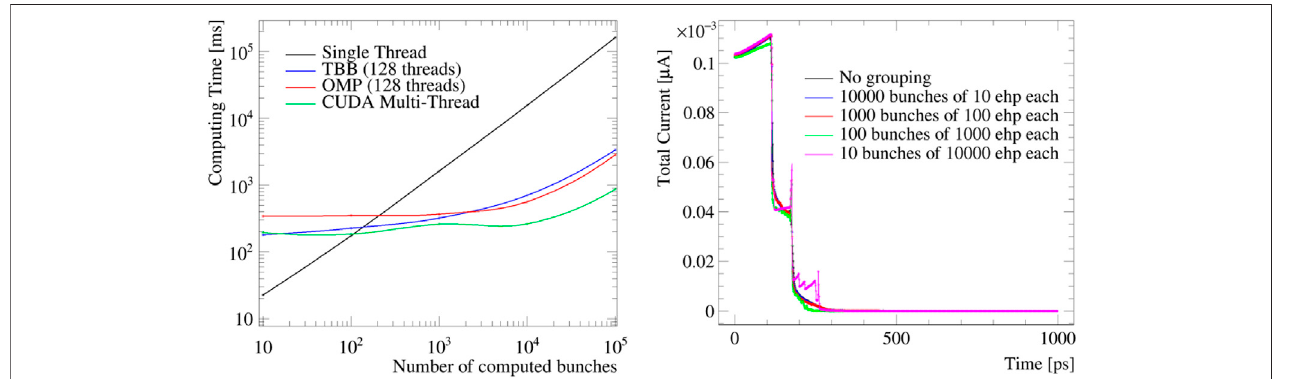
FIGURE 11 | Effects on computing time (left plot) and signal shape by grouping the energy deposits in